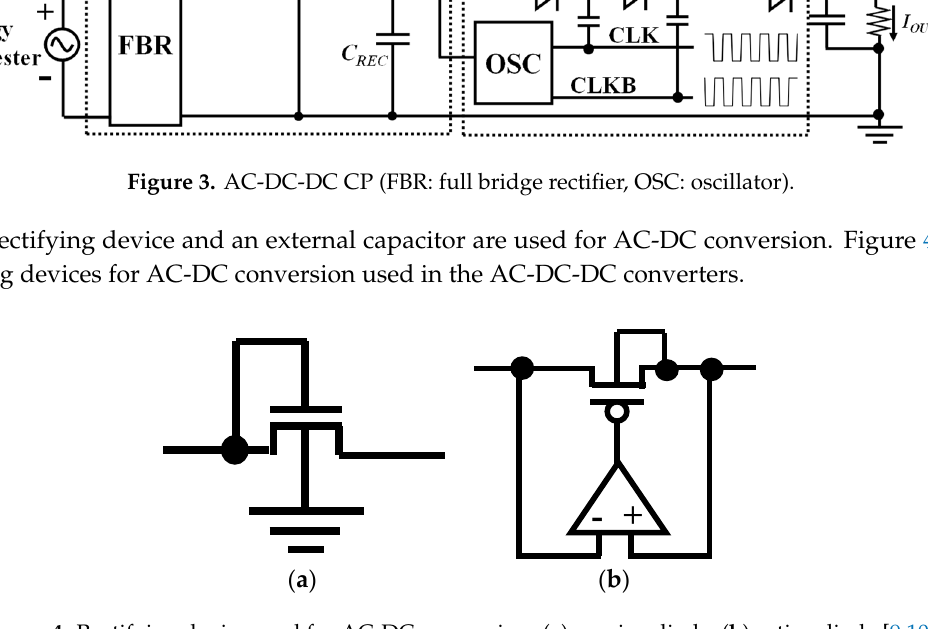
Figure 4. Rectifying device used for AC-DC conversion: ( a ) passive diode, ( b ) active diode [9,10].